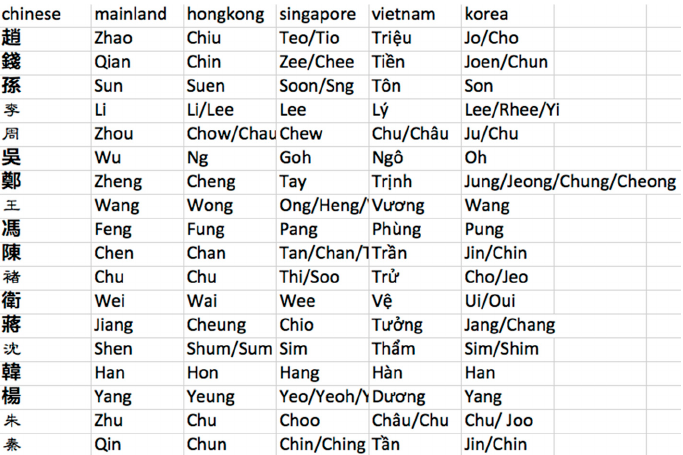
Figure A1. Examples of Common Chinese Surnames and their Romanization of various ethnicities. Notes: Romanization is the conversion of writing from a different writing system to the Roman (Latin) script. Despite the same written form of Chinese, the romanization is different in Mainland China (Mandarin), Hong Kong (Cantonese), Singapore (Singaporean), Vietnam (Vietnamese) and Korea (Korean).